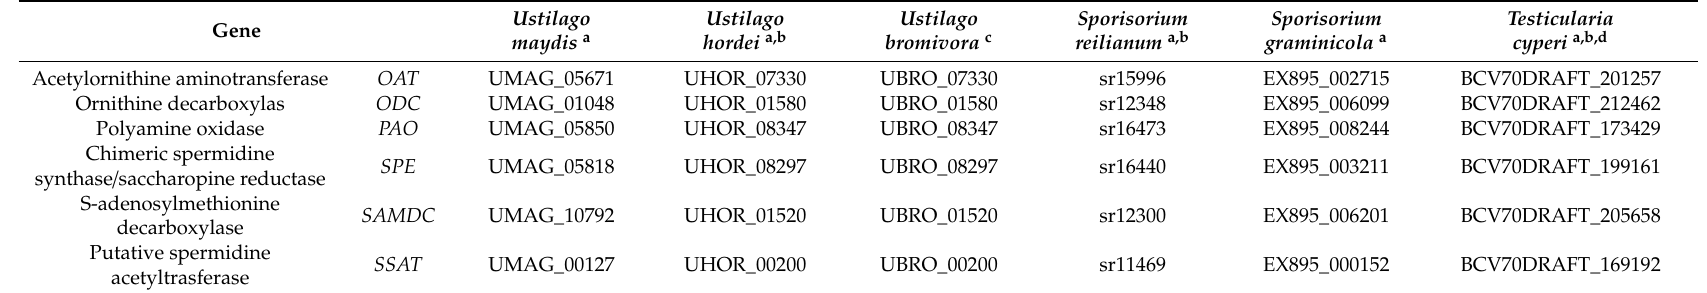
Table 2. Genes involved in the polyamine synthesis pathway of